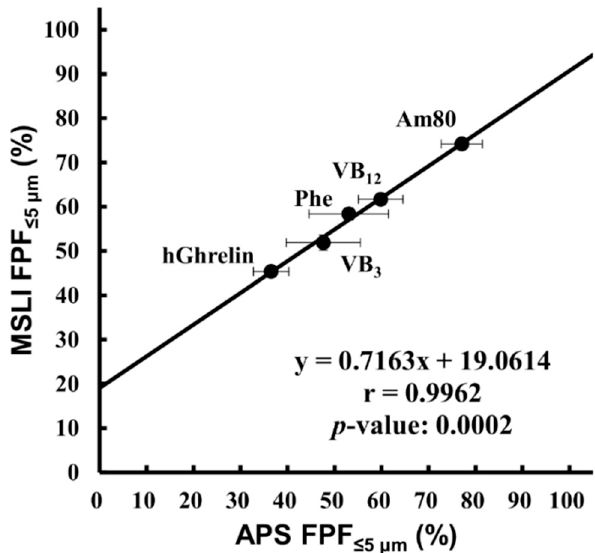
Figure 7. Correlation between MSLI FPF% ≤ 5 µ m and APS FPF% ≤ 5 µ m using the particle density calculated by the conversion factor. Values of APS FPF% ≤ 5 µ m using the particle density described in Table 2 (mean ± S.E., n = 3) were plotted against values of MSLI FPF% ≤ 5 µ m (mean ± S.E., n = 3). MSLI, multi-stage liquid impinger; FPF, fine particle fraction; APS, aerodynamic particle sizer; hGhrelin, hGhrelin formulation containing 0.1 mg / vial of hGhrelin and 0.5 mg / vial of Phe; VB 3, VB 3 formulation containing 0.1 mg / vial of VB 3 and 0.5 mg / vial of Phe; VB 12, VB 12 formulation containing 0.1 mg / vial of VB 12 and 0.6 mg / vial of Phe; Am80, Am80 formulation containing 0.1 mg / vial of Am80 and 0.1 mg / vial of Phe; Phe, placebo formulation containing 0.2 mg / vial of Phe.